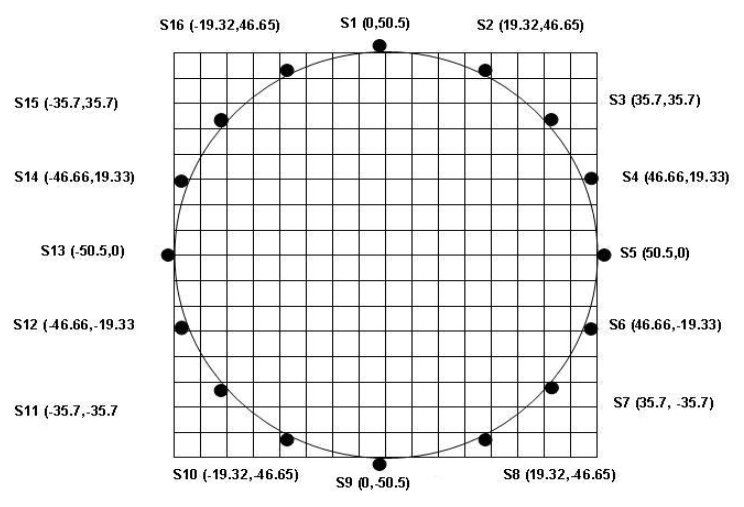
Figure 6. Pipe cross-section and 16 sensor locations with coordinates (x, y).